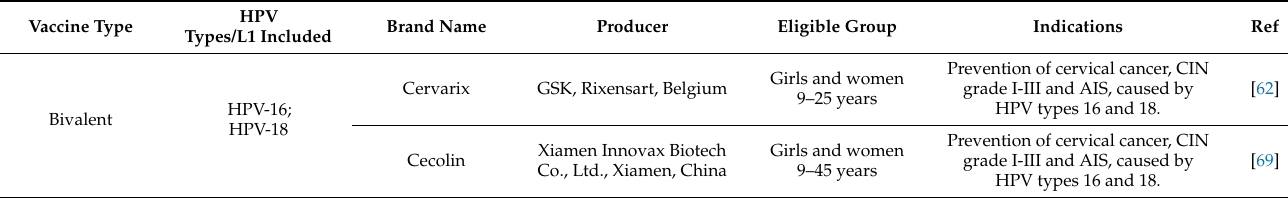
Table 1. Human papillomavirus vaccines’ general